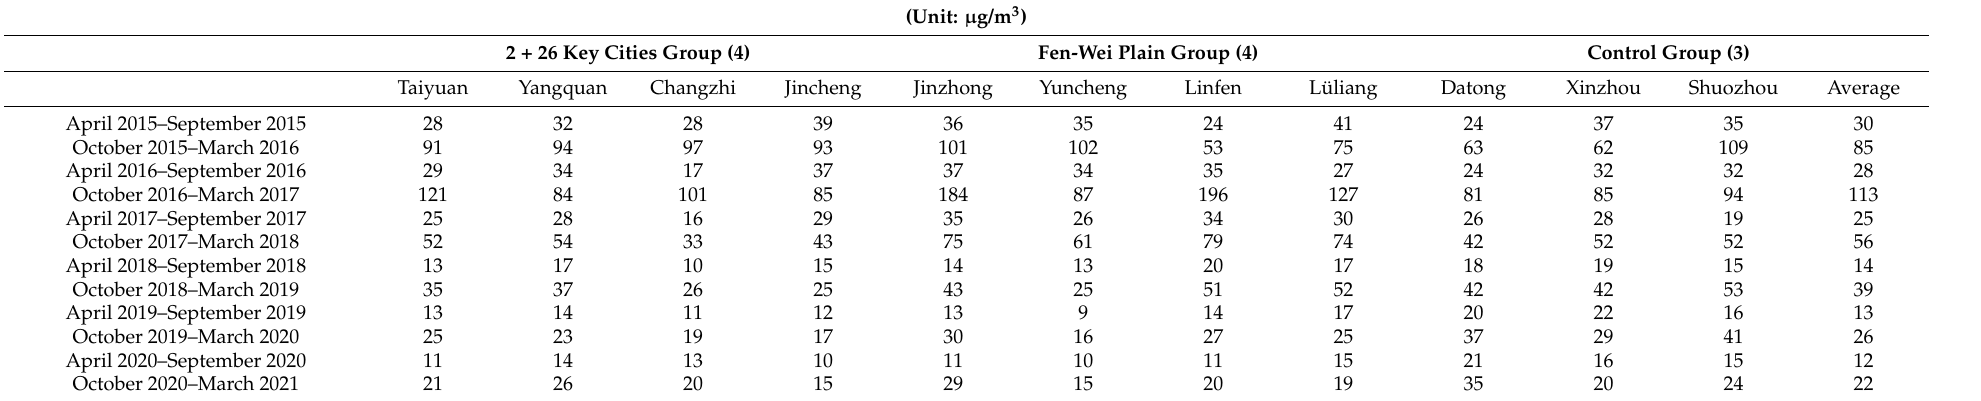
Table 6. Shanxi province’s SO 2 mean concentrations: Spring and summer vs. autumn and winter. (Unit: µ g/m 3